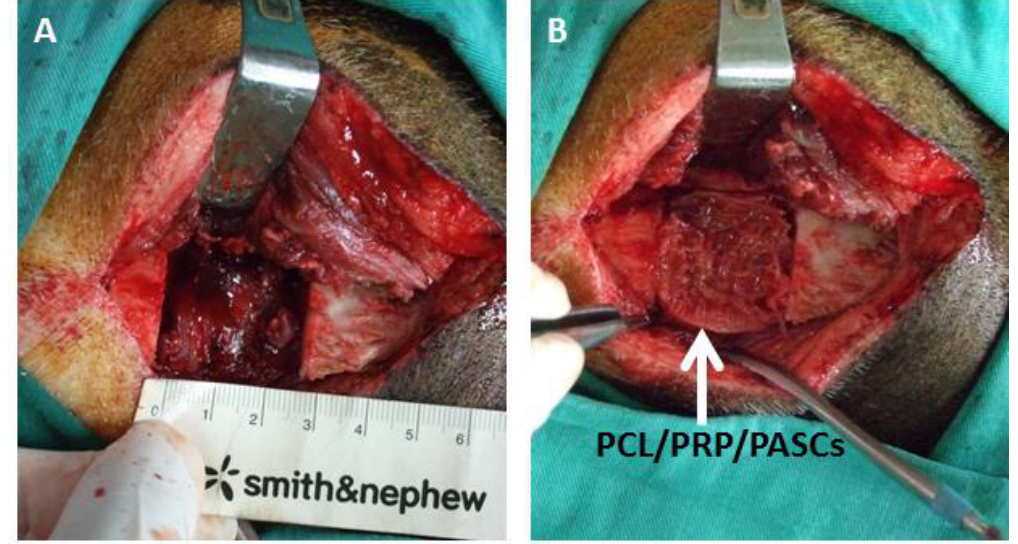
Figure 4. The surgery procedure for bone regeneration with a pig critical-sized mandible defect model. ( A ) A full-thickness 3cm × 3 cm bone defect was created at the lower margin of the mandibular body of a pig, which was reconstructed by ( B ) a tissue-engineered PCL/PRP/PASCs